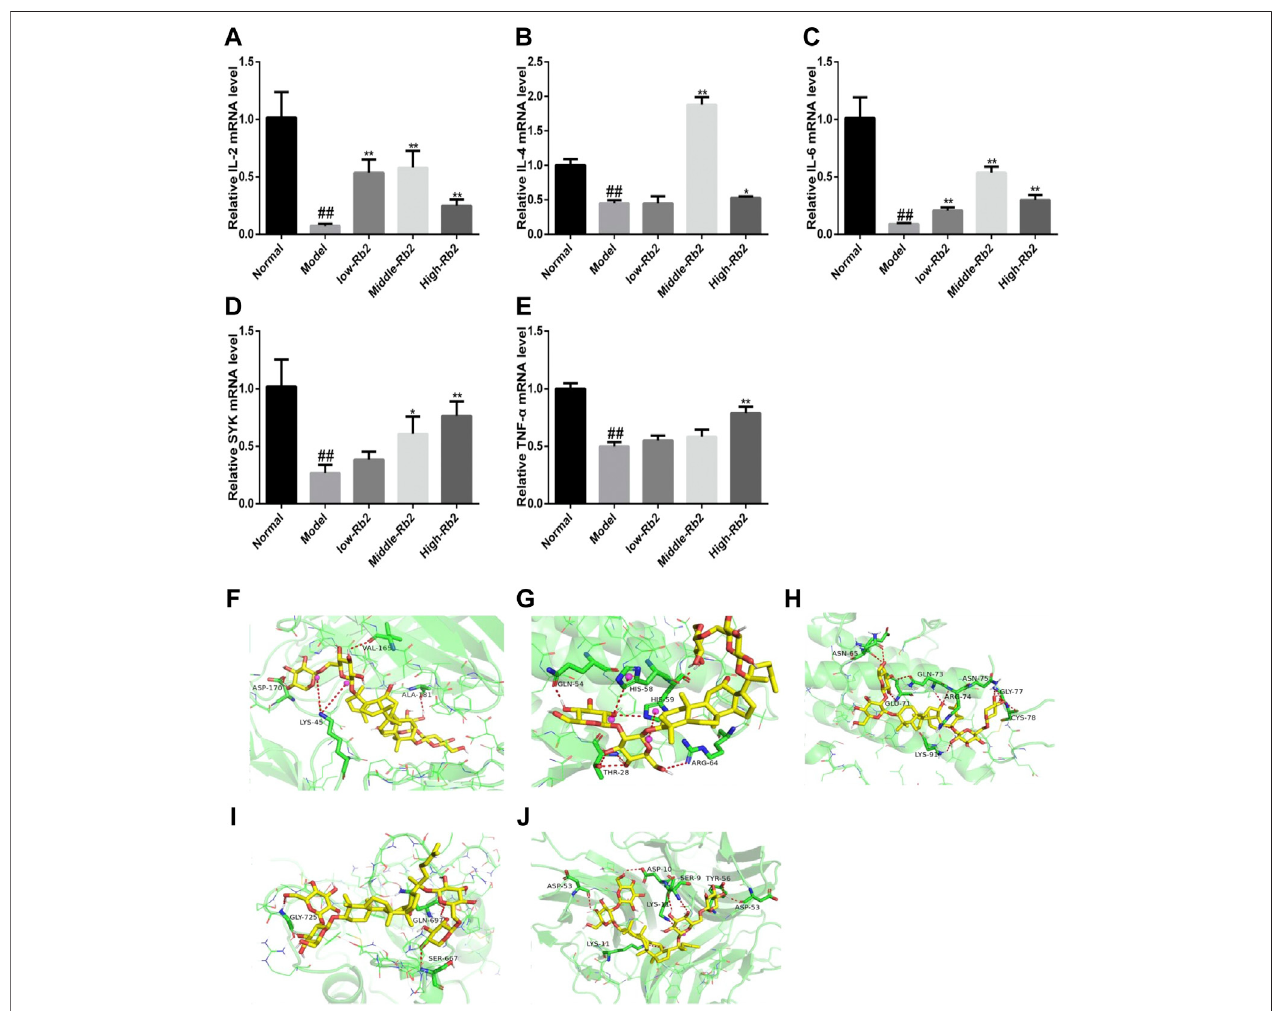
FIGURE 3 | The relative gene expression of cytokines in spleen. (A) , IL-2; (B) , IL-4; (C) , IL-6; (D) , SYK; (E) , TNF- α . ## p < 0.01, compared to Normal. ** p < 0.01, comparedtoModel. (F) DockingofRb2(yellow)intothebindingsiteofmouseIL-2(PDBcode:4yue,green); (G) DockingofRb2(yellow)intothebindingsiteofmouseIL- 4 (PDB code: 2b8u, green); (H) Docking of Rb2 (yellow) into the binding site of mouse IL-6 (PDB code: 2l3y, green); (I) Docking of Rb2 (yellow) into the binding site of mouse SYK (PDB code: 2mc1, green); (J) Docking of Rb2 (yellow) into the binding site of mouse TNF (PDB code: 2tnf, green).